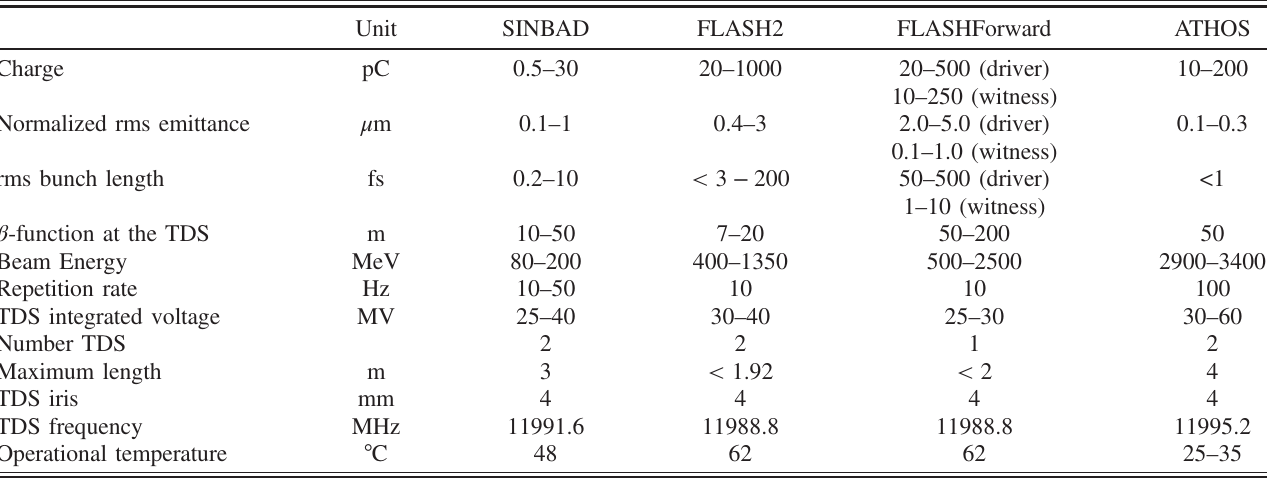
TABLE I. Beam parameters, spatial constraints and specifications for the PolariX TDS design for the experiments at DESY and